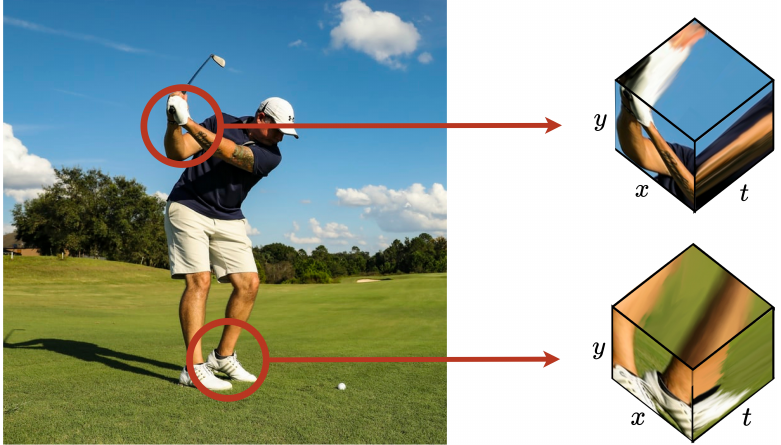
Figure 1. Extraction of local space-time cuboids at interest points in image sequences.